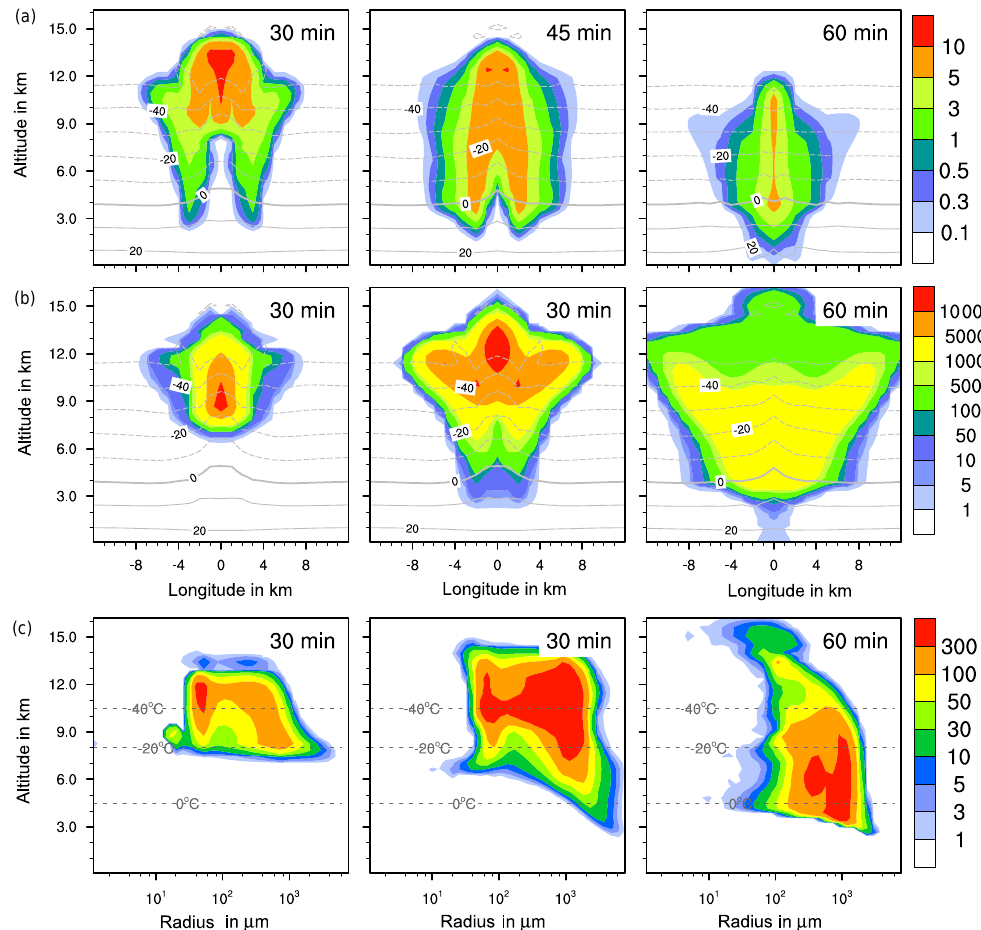
Figure 5. Ice formation from immersion freezing with 1% feldspar. (a, b) Temporal development of two parameters shown in a vertical cut through the cloud center. Horizontal dashed lines: temperature in ◦ C. (a) Ice water contents in gkg − 1 and (b) ice particle numbers per m 3 . (c) Ice particle size spectra in the center cell of the cloud at different times. Number concentrations per m 3 . Left pictures in (b) and (c) show primary immersion freezing